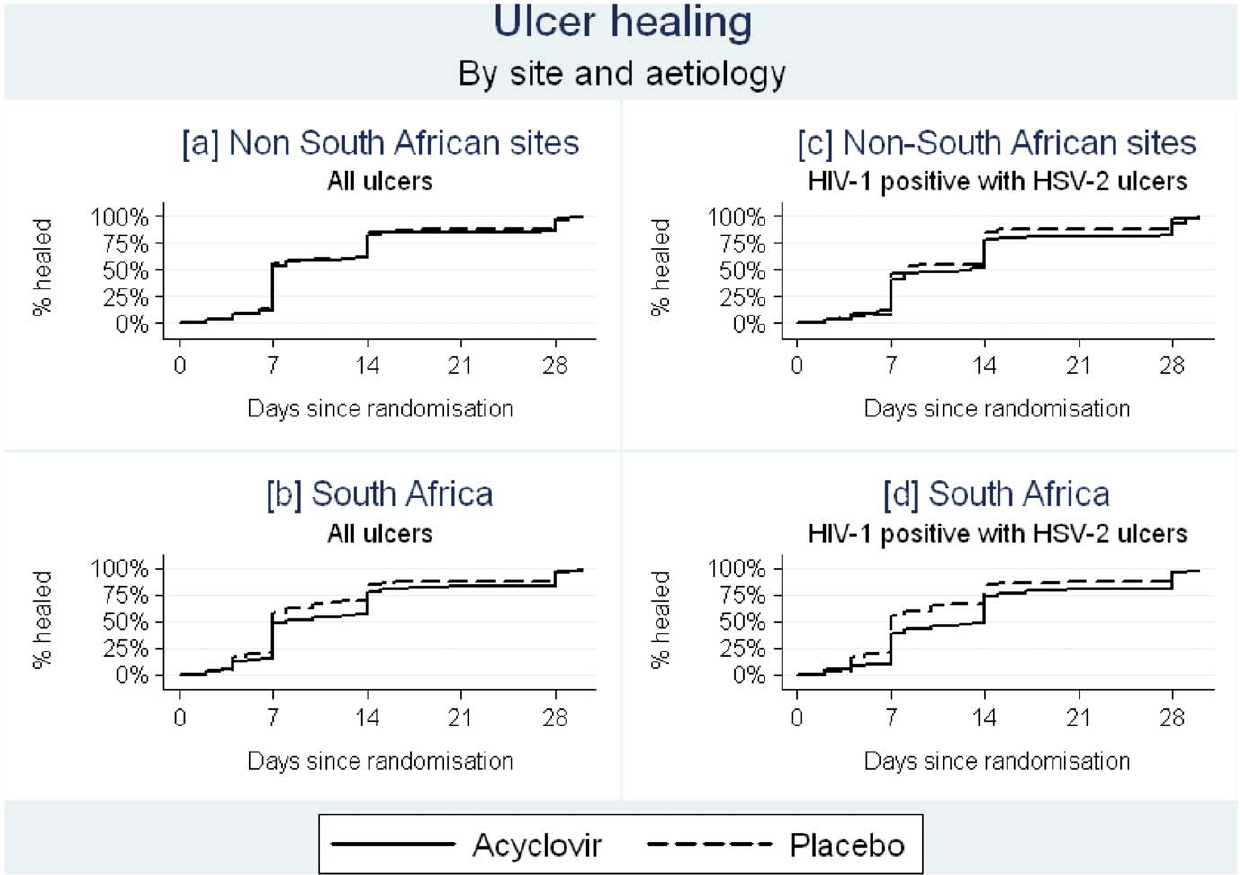
Figure 3. Time-to-ulcer-healing among all patients and those HIV-1 infected with HSV ulcers, by site.